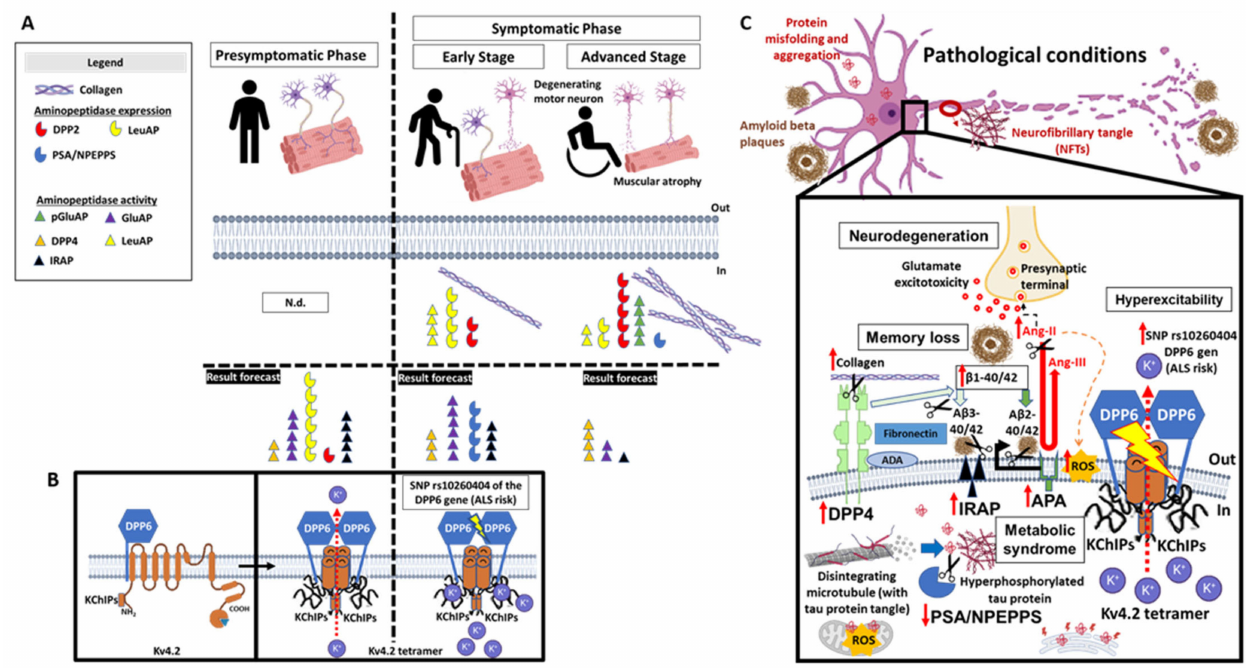
Figure 4. Schematic diagram summarizing ( A ) the most representative results of aminopeptidases found in studies of patients with early and advanced stage amyotrophic lateral sclerosis. The need to use aminopeptidases as pre-diagnosis markers hypothesize the early possibility of detecting the disease before manifesting neurodegenerative motor symptoms (result forecast). The aminopeptidase DPP6 ( B ) binds to voltage-gated potassium channels (Kv4.2), but variations in the expression of the DPP6 gene alter the biological functions of the potassium channel, causing motor neuron hyper- excitability. Schematic representation ( C ) of the deregulation of aminopeptidases that manifest in neurodegenerative diseases (amyotrophic lateral sclerosis, Alzheimer’s disease, Parkinson’s, Hunting- ton’s) with common metabolic processes. The similarity in these processes can become an advantage, and aminopeptidases can be used as a diagnostic tool for the detection of multiple neurodegenerative pathologies. DPP4 is involved in collagen remodeling, but it is also involved in amyloid beta plaque degradation along with IRAP, leading to memory problems (green arrows). The overactivation of the renin-angiotensin system (red curved arrow) contributes to a high production of Ang-II, leading to neurodegeneration due to the release of glutamate and causing ROS by oxidative stress (orange dotted arrow); all of them are factors associated with metabolic syndrome. APA allows the conversion of Ang-II to Ang-III. In ALS patients, the neuroprotective enzyme PSA/NPEPPS is reduced, known to hydrolyze misfolded and aggregated proteins (such as mutated SOD1 and hyperphosphorylated tau) that cause mitochondrial, Golgi apparatus, and nuclear damage. Genetic variants of the DPP6 gene (SNP rs10260404) reduce potassium leakage in Kv4.2 potassium channels (red dotted